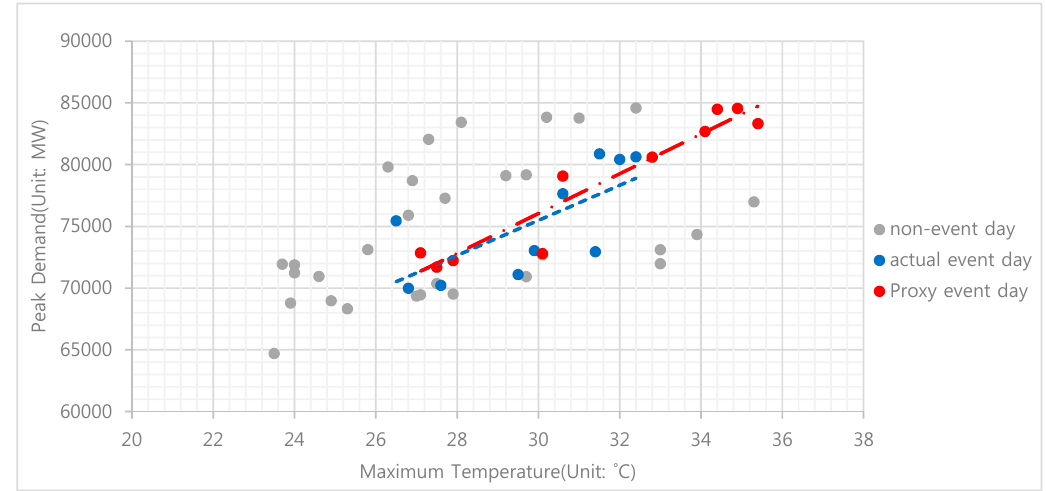
Figure 4. Actual event days compared to proxy event days 4.2. Free rider problem.